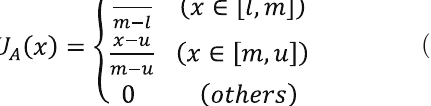
Figure 1: WBS-RBS coupling